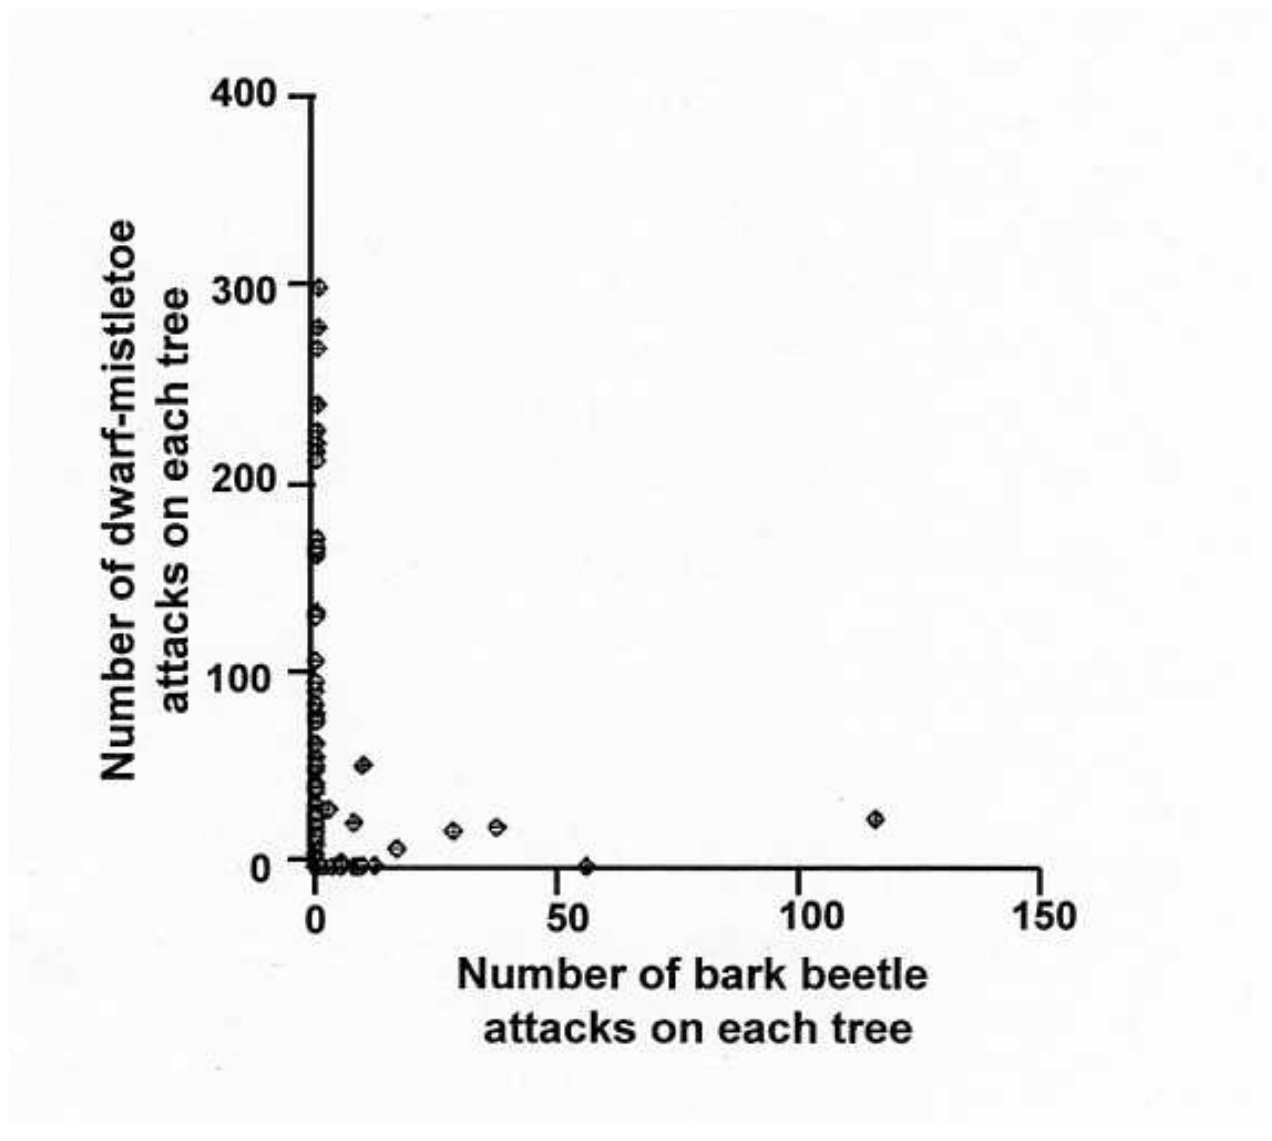
beetles and dwarf mistletoe (after Linhart et al.